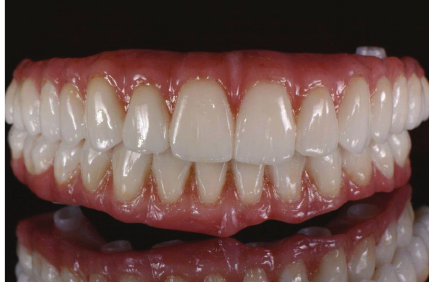
Figure 11: Intraoral frontal view of the final